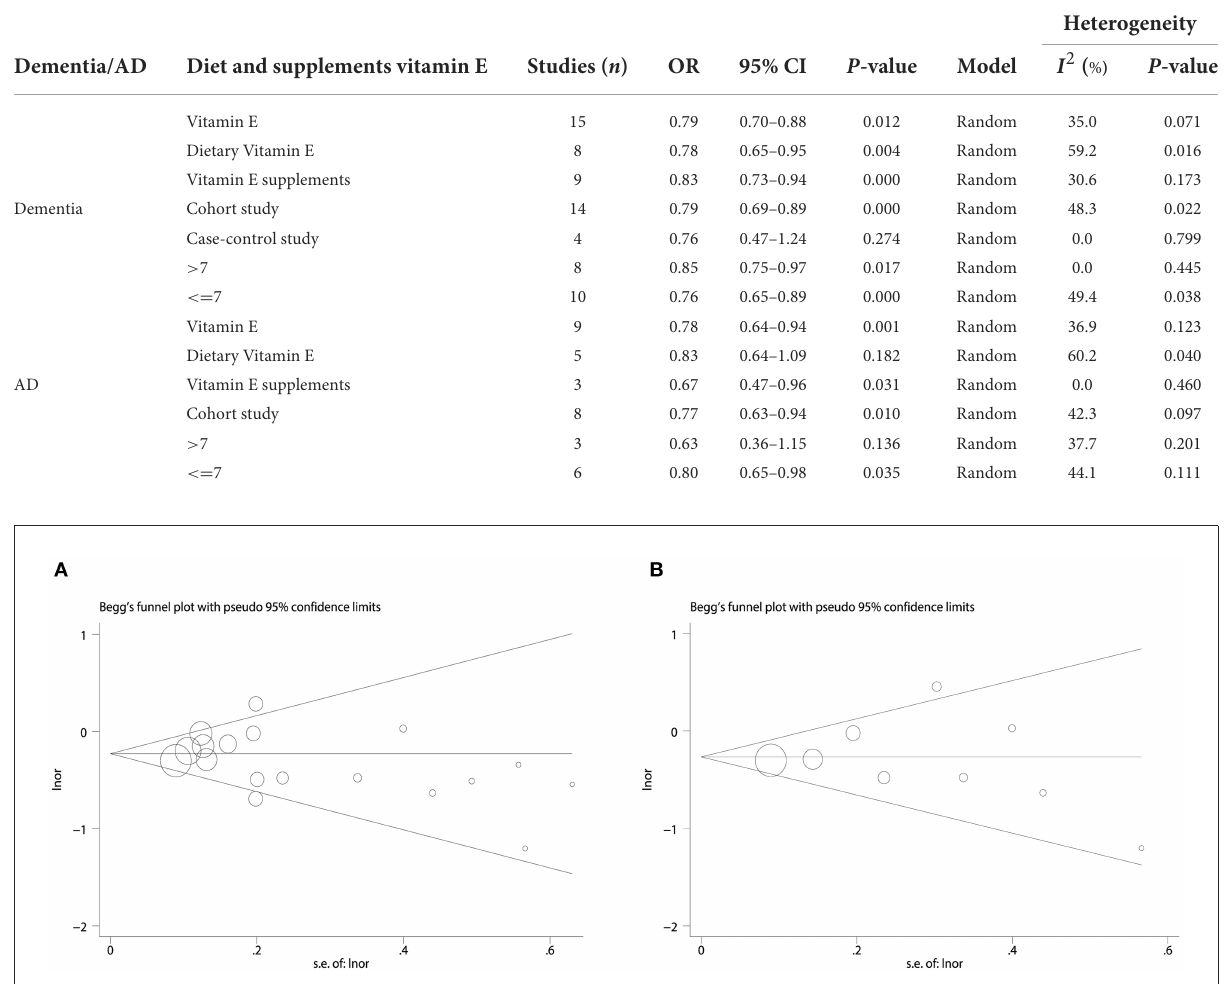
TABLE 2 Meta-analysis of diet and supplements with risk of dementia.